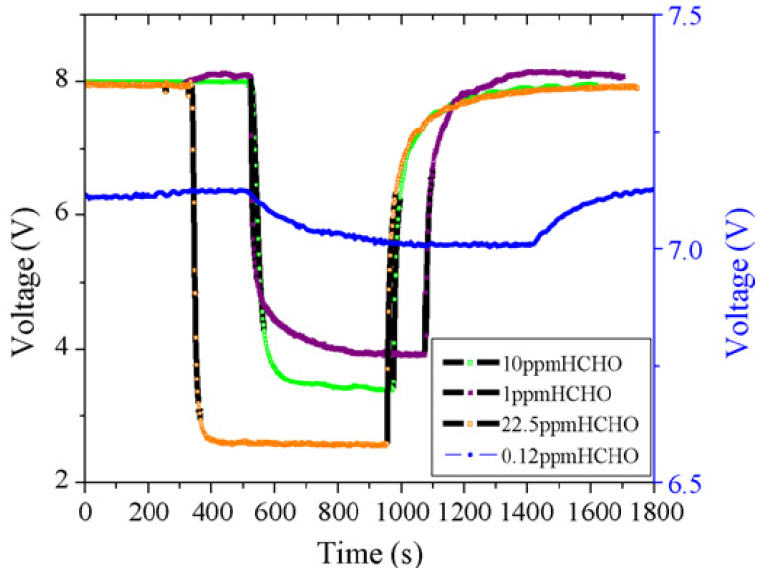
Figure 4. Response curves as a function of formaldehyde concentration in a micro-hotplate metal oxide sensor, reprinted from [28] with permission from